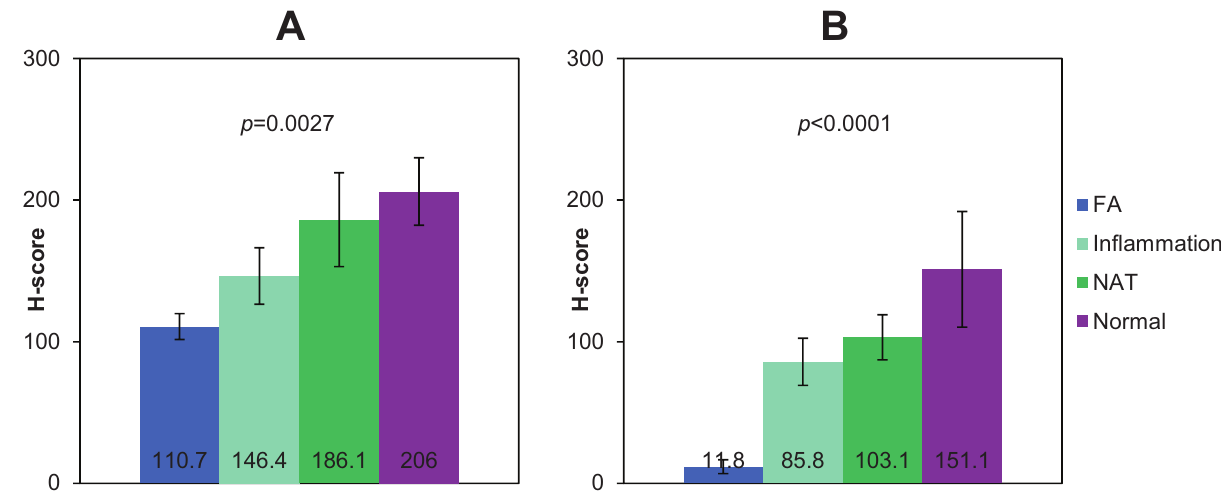
Figure 2. Analysis of expression of CX 3 CR1 ( A ) and CX 3 CL1 ( B ) in human specimens of fallopian adenocarcinoma (FA; n = 10), fallopian tube with chronic inflammation (Inflammation; n = 11), cancer adjacent normal oviduct tissue (NAT; n = 4), and normal fallopian tube epithelium (Normal; n = 5), as indicated. Graphs demonstrate average h-scores ± standard error. Numbers in the center of the bars indicate average h-scores. Data were statistically analyzed with one-way